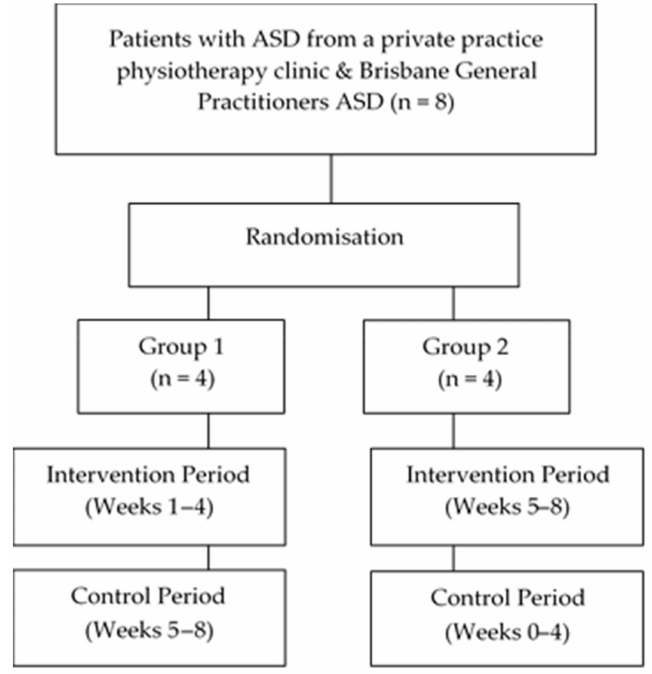
Figure 1. Flow of patients throughout the